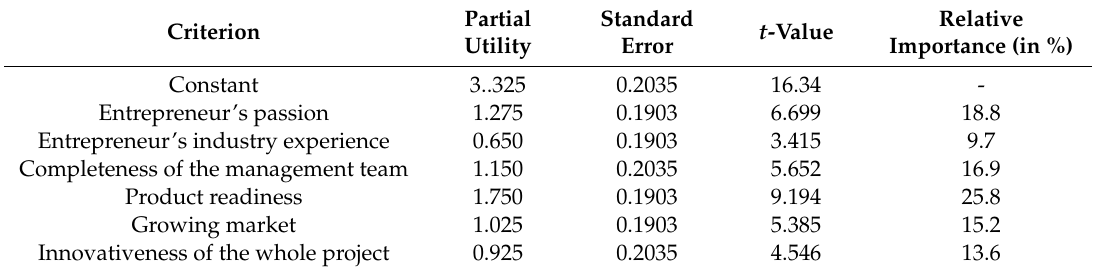
Table 7. Results of conjoint experiment: importance of six investment criteria assessed by VC